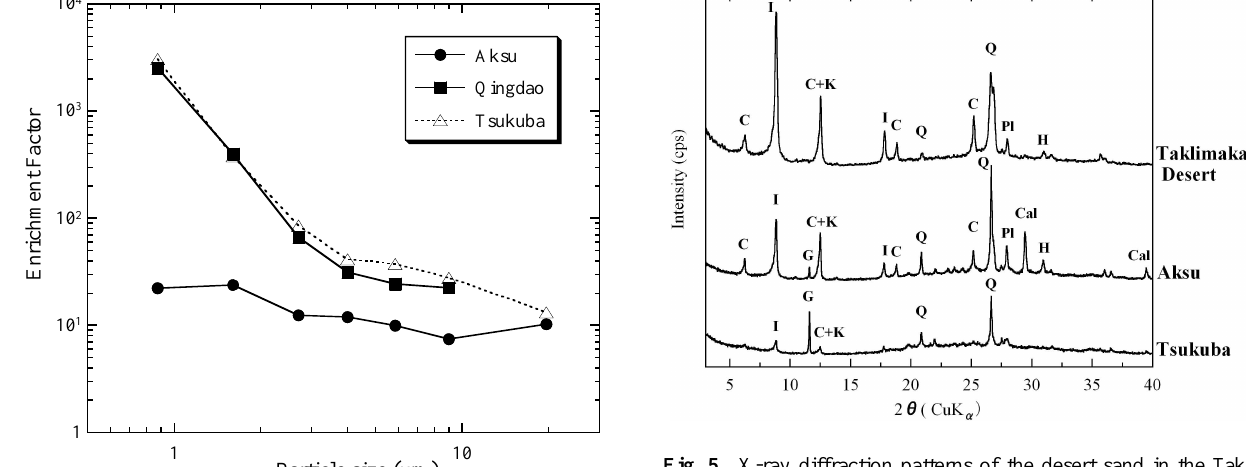
Fig. 5. X-ray diffraction patterns of the desert sand in the Takli- makan Desert and total suspended particulates (TSP) collected at Aksu and Tsukuba without filter. The desert sand less than 2mm was separated from the bulk sample by sedimentation in water based on Stokes’ settling law. I, illite; C, chlorite; Q, quartz; C+K, chlo- rite+kaolinite; G, gypsum; Pl, plagioclase; Cal, calcite; H,